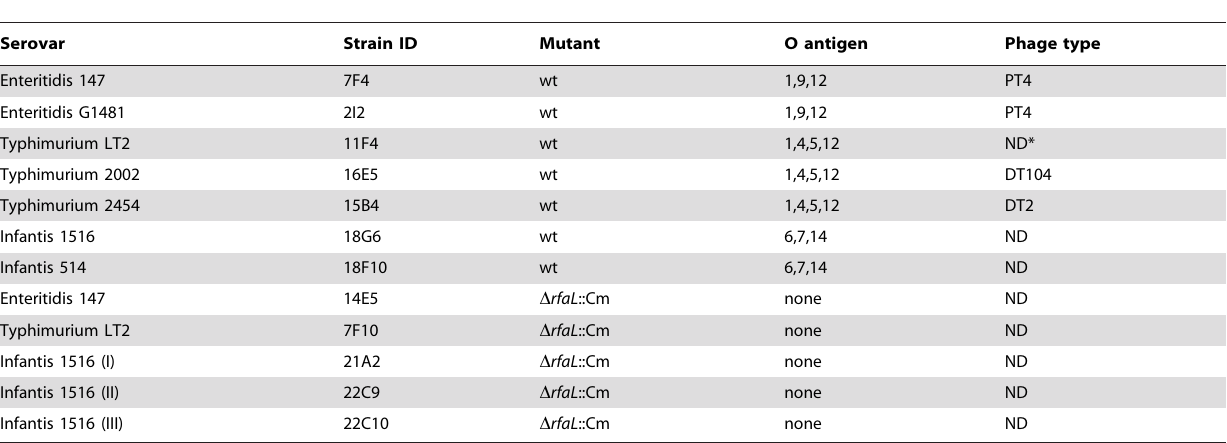
Table 1. List of Salmonella enterica strains and their rfaL mutants used in this study.